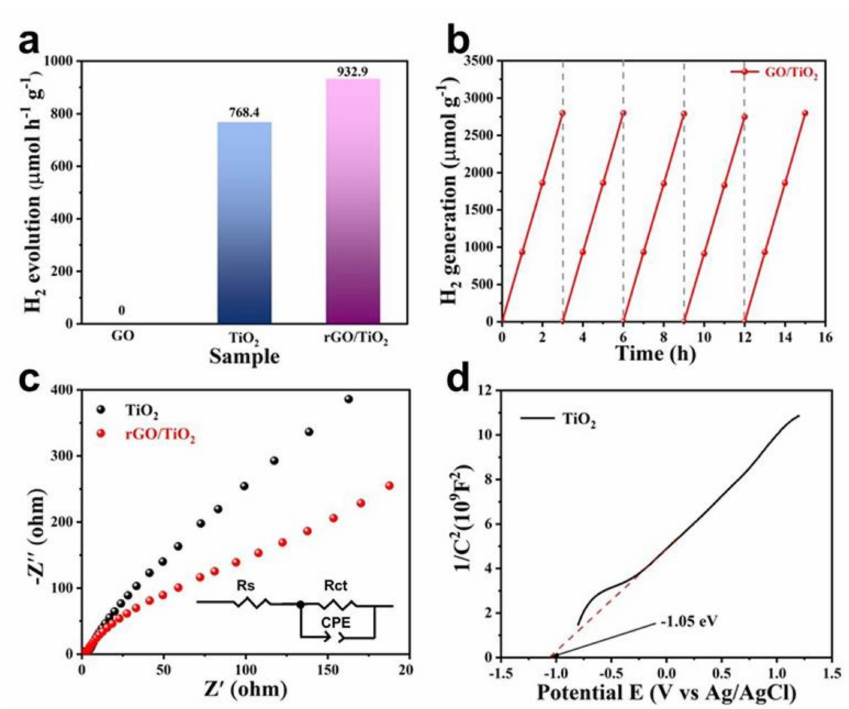
Figure 3. ( a ) Photocatalytic H 2 evolution rate of rGO, TiO 2 and rGO/TiO 2 , ( b ) recycling tests of rGO/TiO 2 , ( c ) the Nyquist plots of electrochemical impedance under AM 1.5G of TiO 2 and rGO/TiO 2 , and ( d ) the Mott–Schottky plots of TiO 2